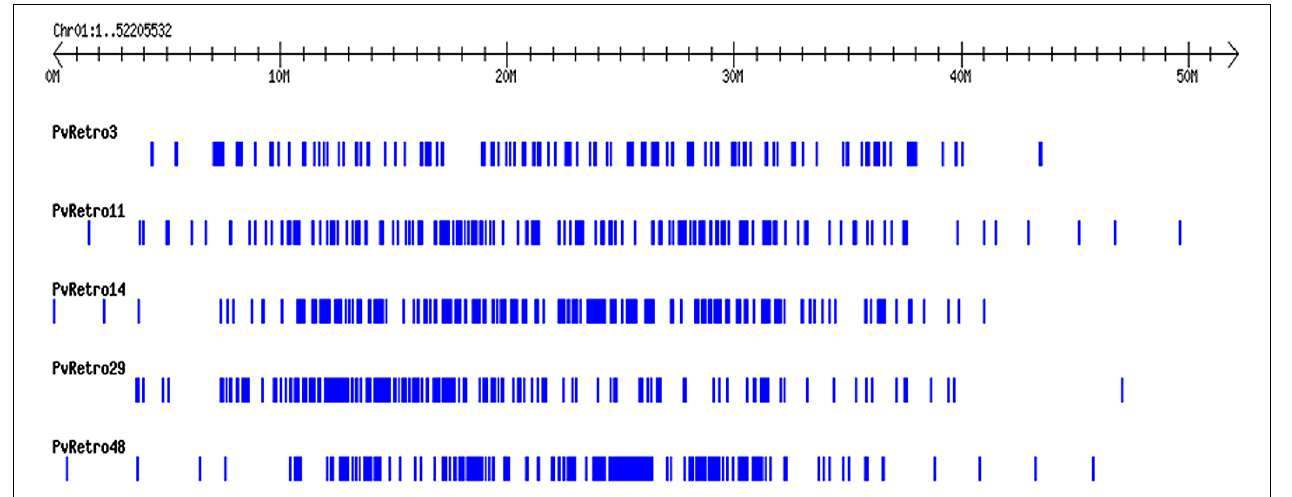
FIGURE 4 | Distribution of five LTR retroelement families on the chromosome 1 of common bean. The distribution patterns of the five transposons across other nine chromosomes are not shown as they are similar to chromosome